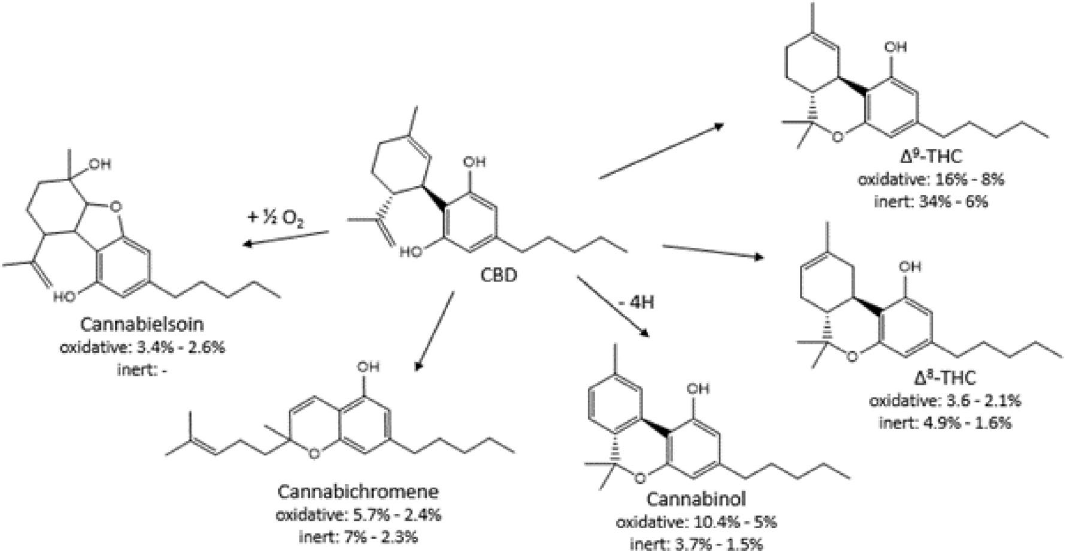
Figure 1. The major thermal decomposition routes of CBD in inert (helium) and oxidative (9% oxygen in nitrogen) atmosphere in a temperature range of 250–500